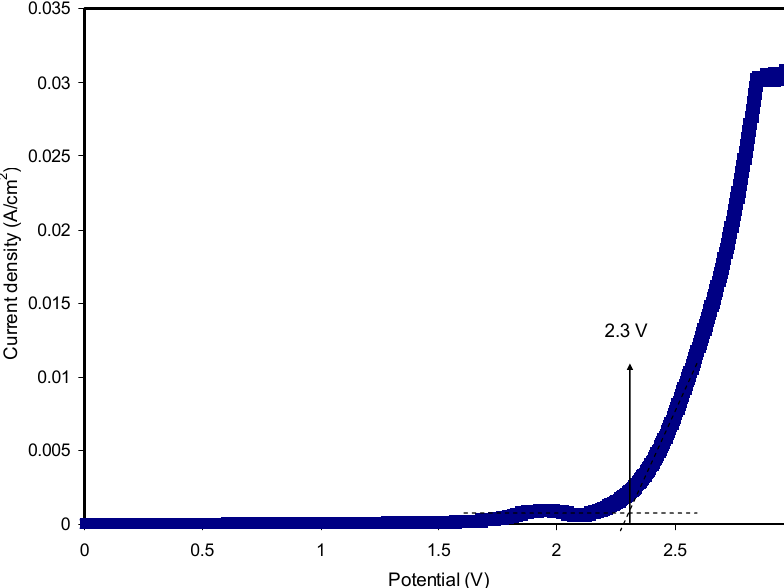
Figure 9. TNM plot for the highest conducting solid polymer electrolyte (SPE) with a polarization voltage of 0.2 V.